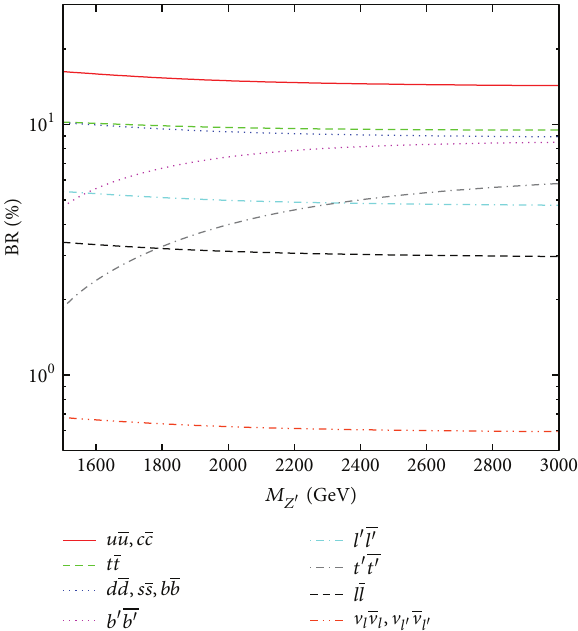
Figure 2: Branching ratios (%) depending on the mass of 𝑍 󸀠 boson for diagonal couplings to quarks and leptons within the 𝑍 󸀠 𝜂 model. Thenewheavyquarkmassesaretakentobe700 GeV,andnewheavy charged lepton mass is 200GeV and new heavy neutrino mass is 100